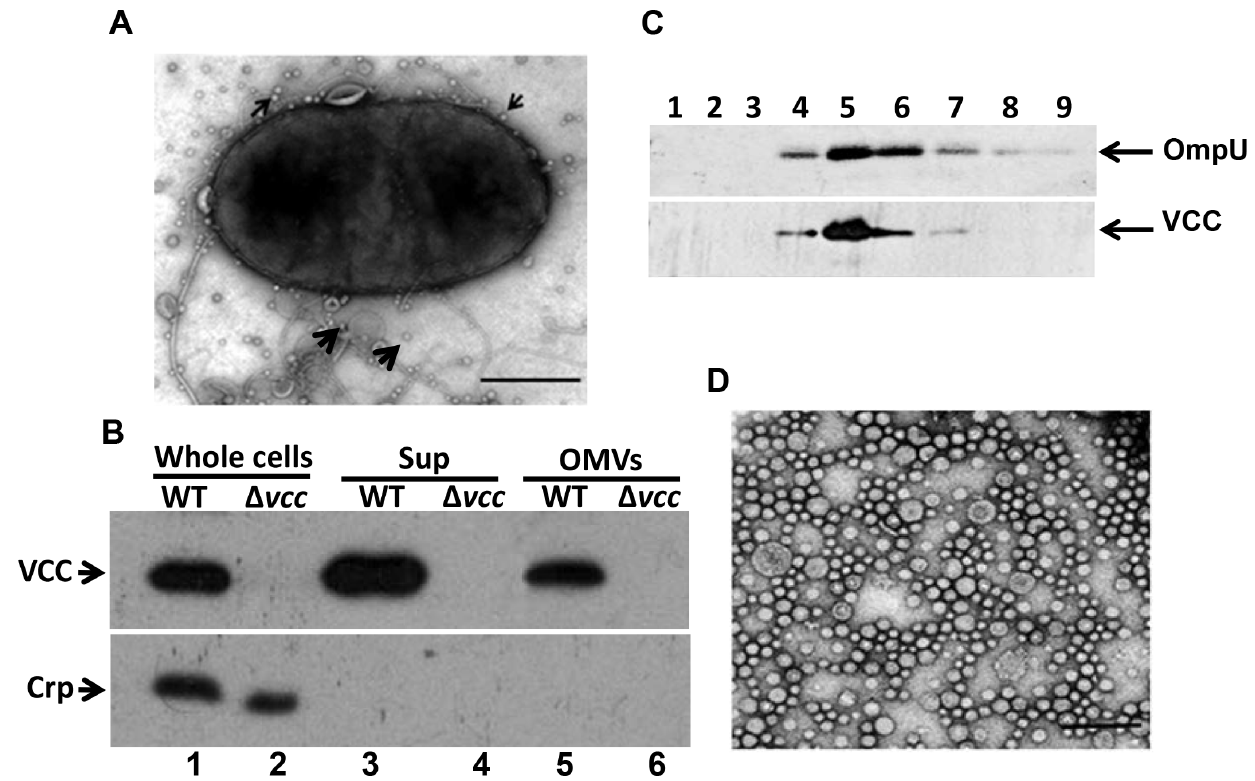
Figure 2. Ultrastructural and immunoblot analyses of OMVs. (A) Electron micrograph of a bacterial cell. OMVs released from the surface of the bacterial cell are shown (arrows). Bar=200 nm. (B) Upper panel: Immunoblot analysis of the VCC in whole cell lysate (lanes 1, 2), supernatant [sup (lanes 3, 4)], and outer membrane vesicles [OMVs (lanes 5, 6)] from NOVC strain, V:5/04 (lanes 1, 3, 5) and its vcc mutant (lanes 2, 4, 6), respectively. Lower panel: A cytosolic protein (Crp) was used as an internal control. (C) Immunoblot analysis of protein fractions obtained by Optiprep density gradient centrifugation. Lanes 1–9 represents fractions 4–12 respectively. The arrows show OmpU and the VCC protein immunoreactive bands. (D) Electron micrograph of a purified OMV sample. Negative staining of the sample was performed as described in the material and methods. Different OMV sizes were observed by electron microscopy. Bar=200 nm.